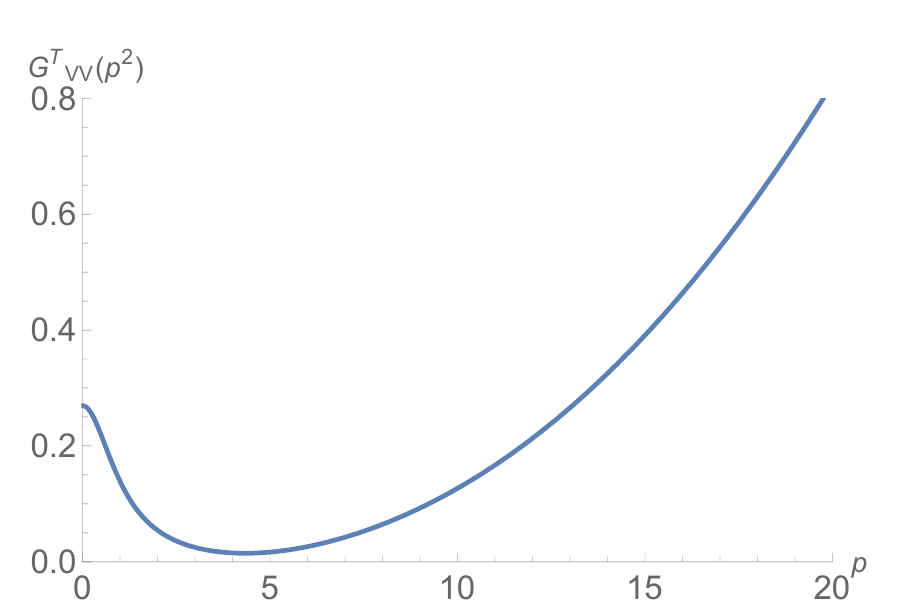
Figure 6 . Resummed propagator for the vector composite operator. All quantities are given in units of appropriate powers of the energy scale (cid:22) , with the parameter values e = 1, v = 1 (cid:22) , (cid:21) = 1